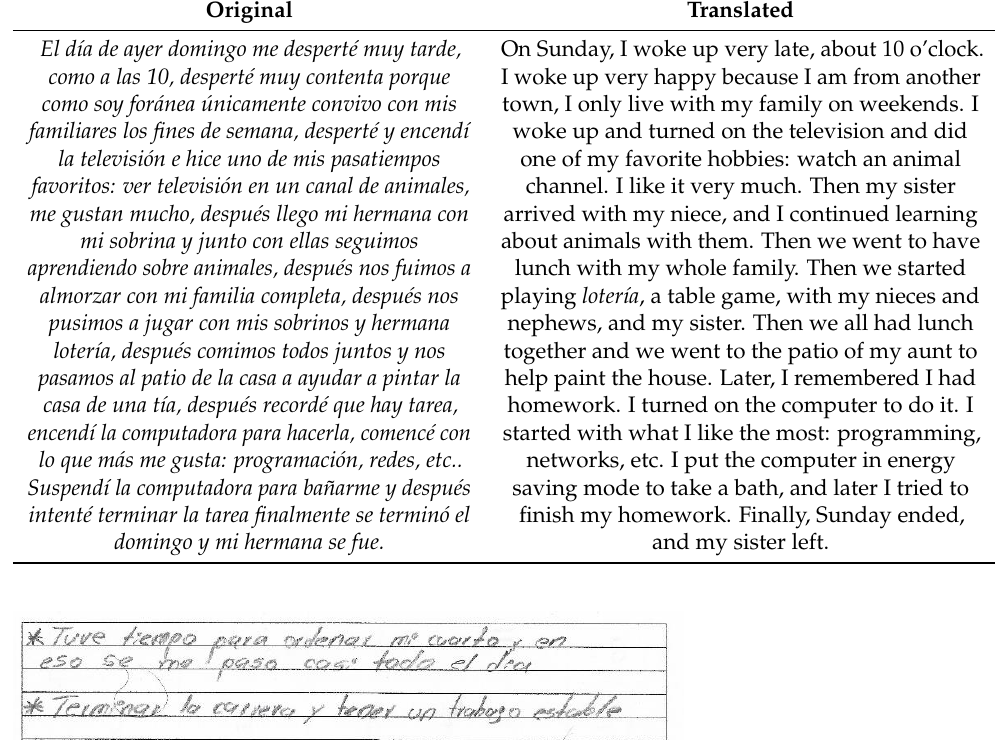
Table 4. Example of a Spanish text gathered in the survey.